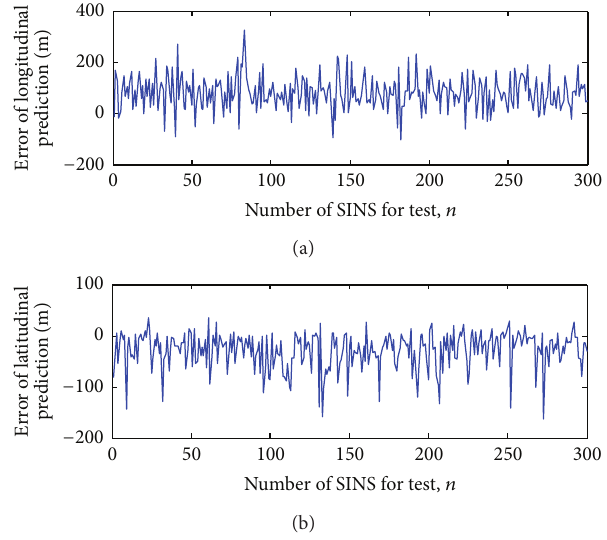
Figure 4: Prediction errors generated by SVM.